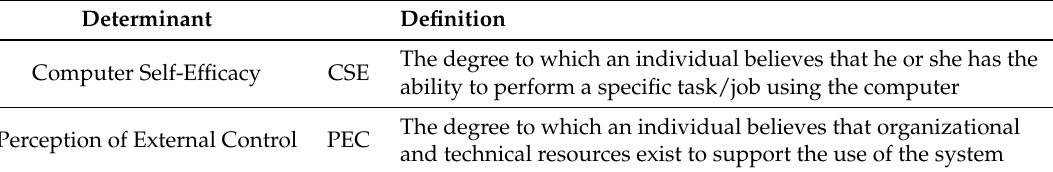
Table 3. Determinants for perceived ease of use.